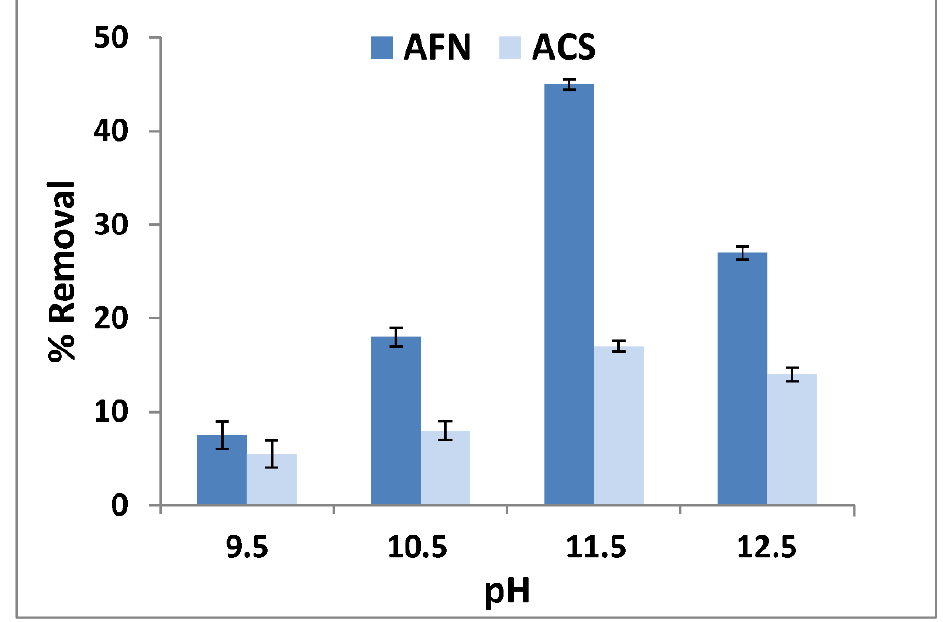
Figure 2. pH effects on the removal rate of boron.